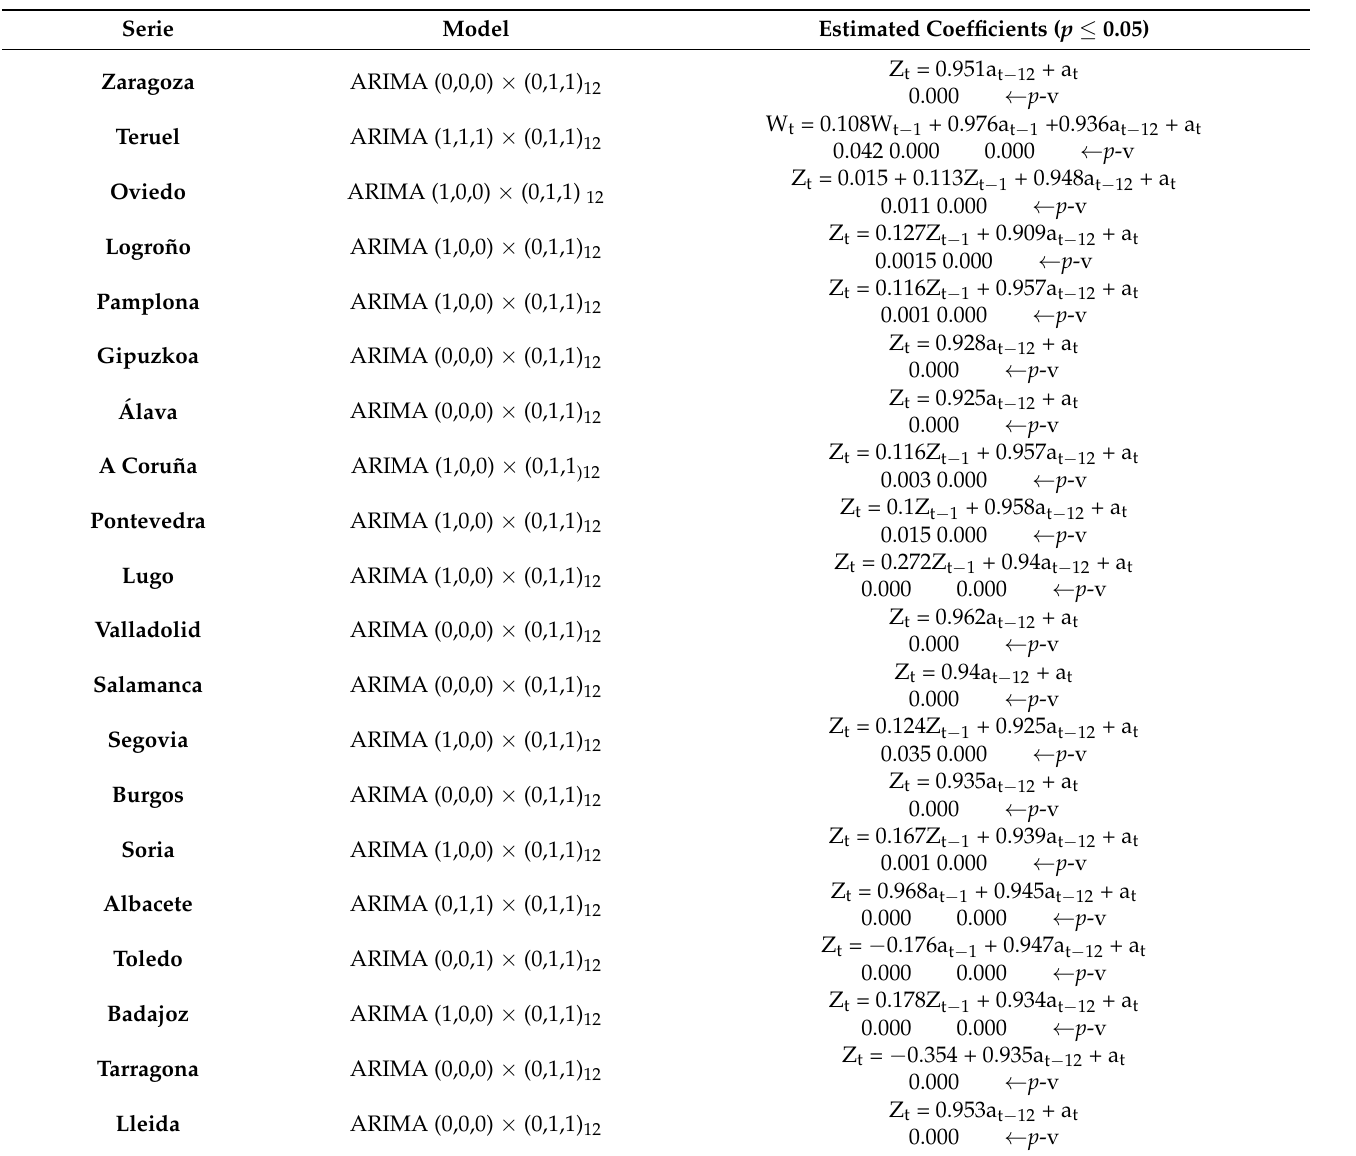
Table 5. ARIMA models of the 27 precipitation